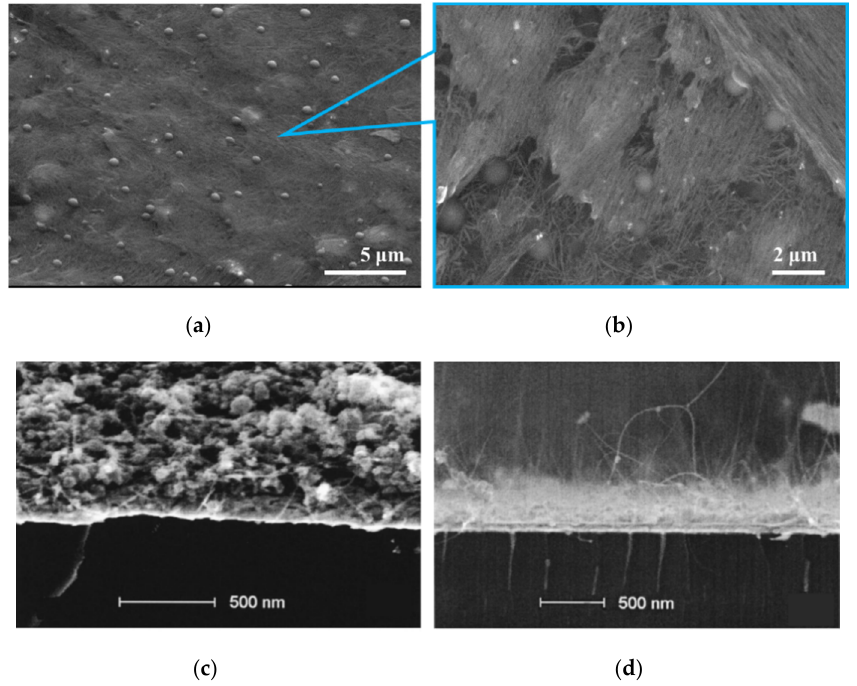
Figure 12. CNT matrix films made of CNT suspension: ( a , b ) The SEM images of the CNT film made of dried suspensions, between CNTs there are visible additives in a form of balls; ( c ) the SEM image of CNT film with additives and ( d ) after they were removed; Figure 12a,b from author’s work. Figure 12c,d reprinted with permission from [133].